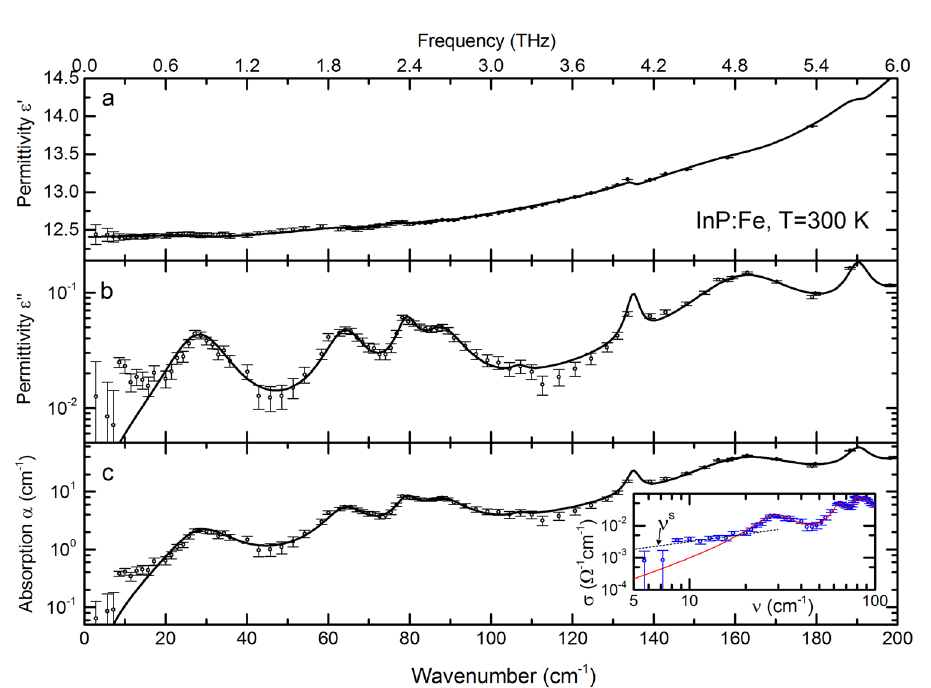
Figure 3. Room temperature low-frequency spectra of the real ε ʹ ( a ) and imaginary ε ″ ( b ) parts of the dielectric permittivity and a low-frequency spectrum of the absorption coefficient α ( c ) of Fe-doped InP. The dynamical conductivity σ is shown in the inset in panel ( c ). Dots are experimental data, solid lines are the modeling curves described in the main text. Dotted line in the inset corresponds to the Mott’s expression describing the hopping contribution, σ ( ν ) ∝ν s with s = 0.9. The parameters of the absorption lines (cf. Eq. (1)) are presented in Table